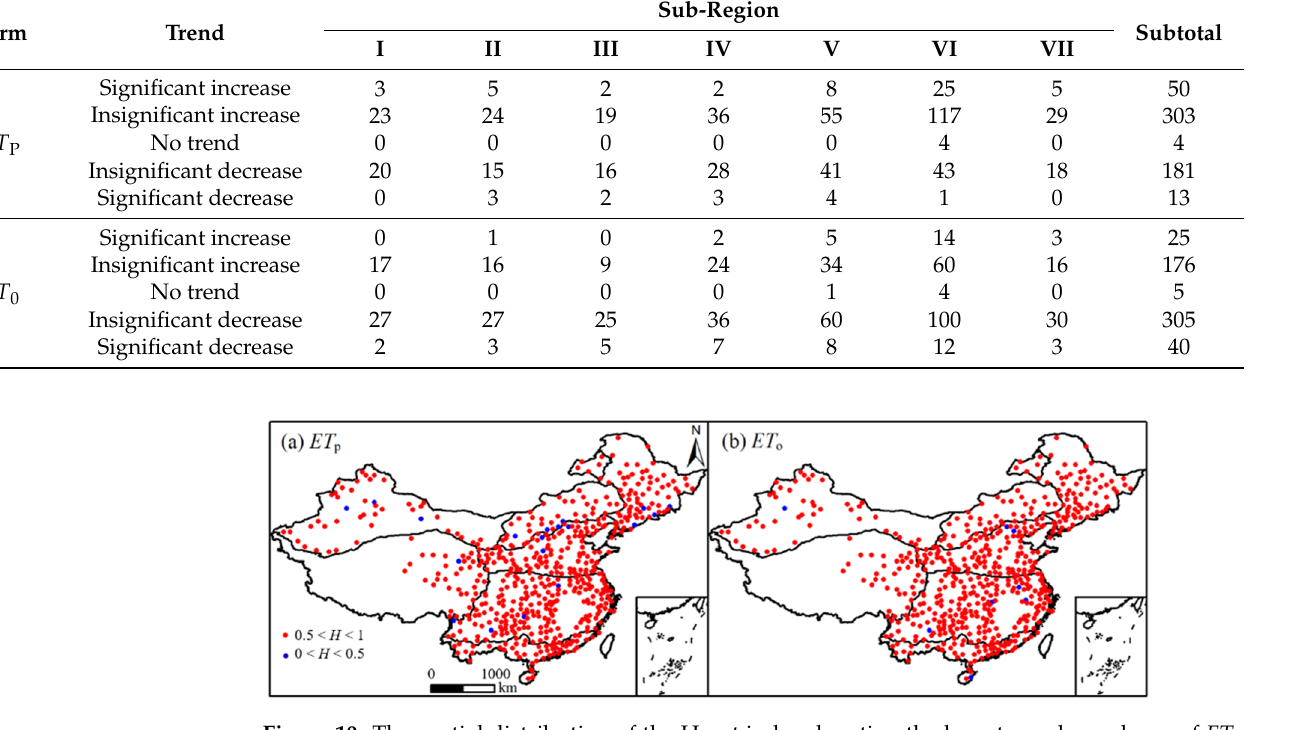
Figure 10. The spatial distribution of the Hurst index denoting the long-term dependence of ET p and ET o . Table 3. The station numbers of the Hurst coefficient for annual ET o and ET p in different